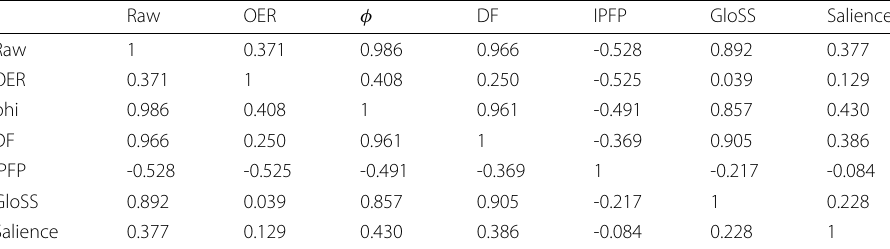
Table 9 The correlation matrix for the PageRank of nodes between different networks Raw OER φ DF IPFP GloSS Salience